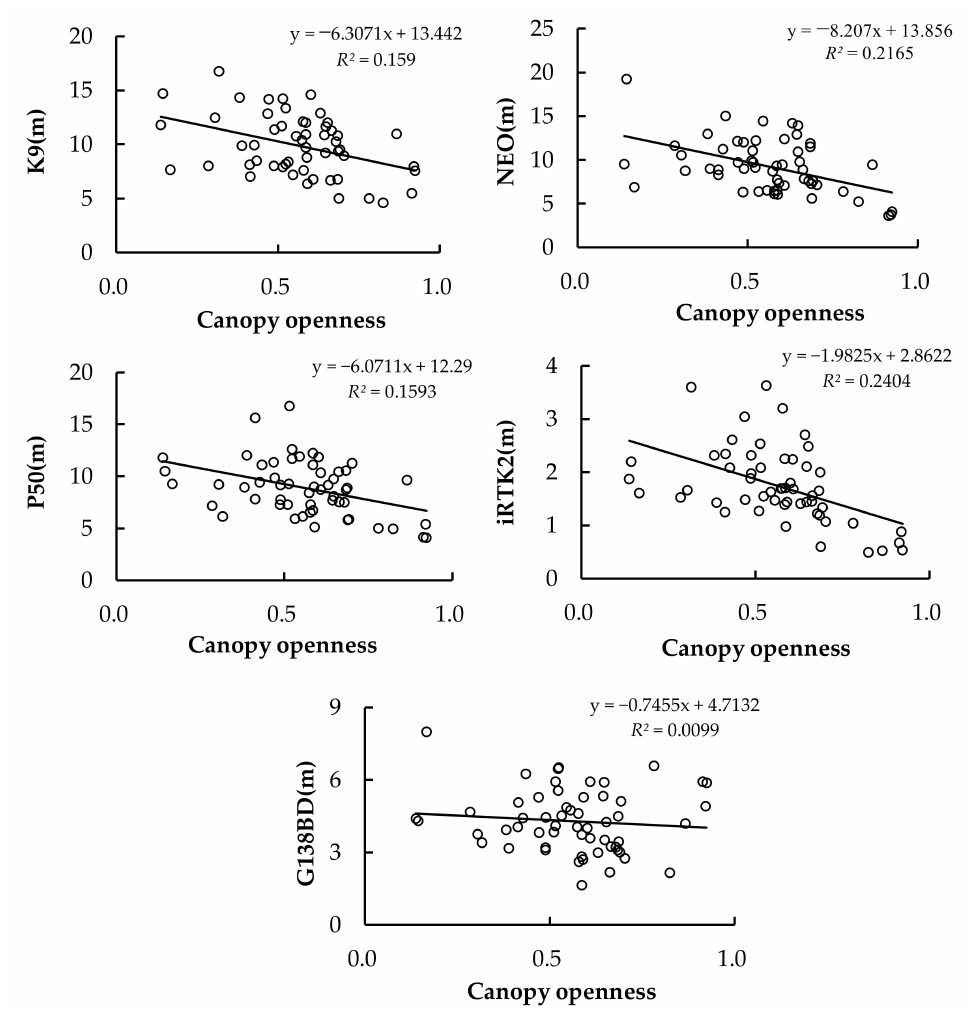
Figure 10. Horizontal distance root mean square error (DRMS) of SPP model under different